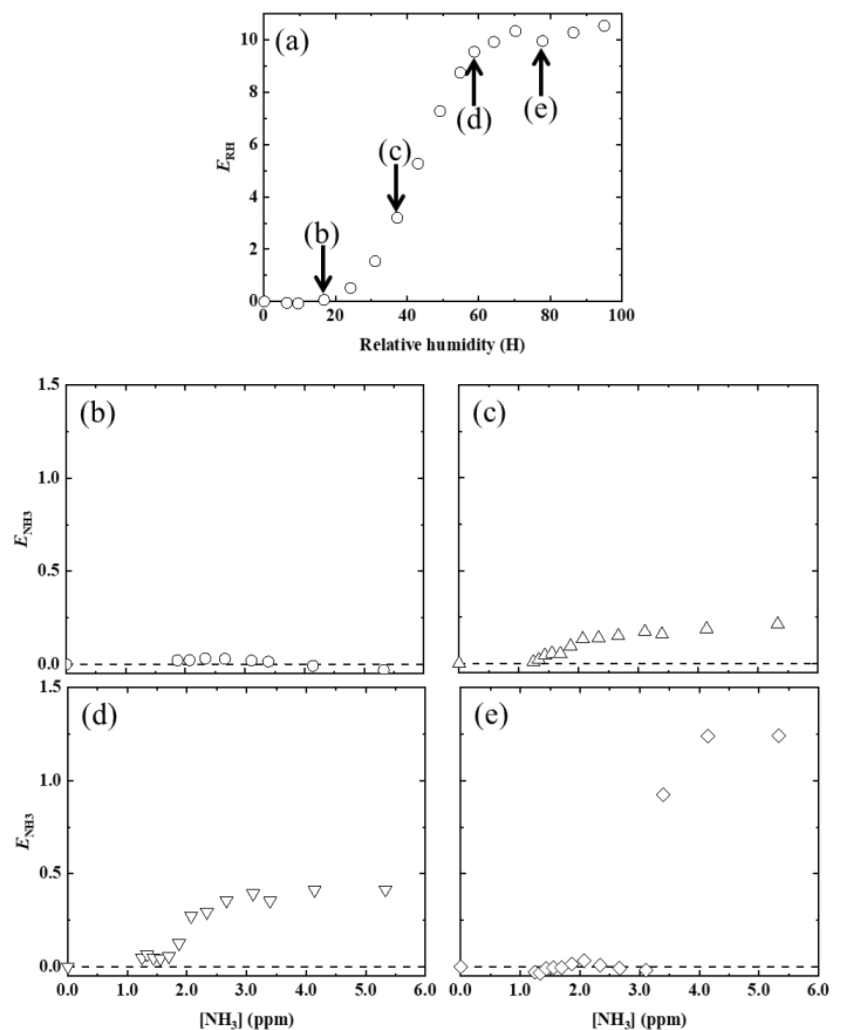
Nanomaterials 2021 , 11 , x FOR PEER REVIEW 6 of 9